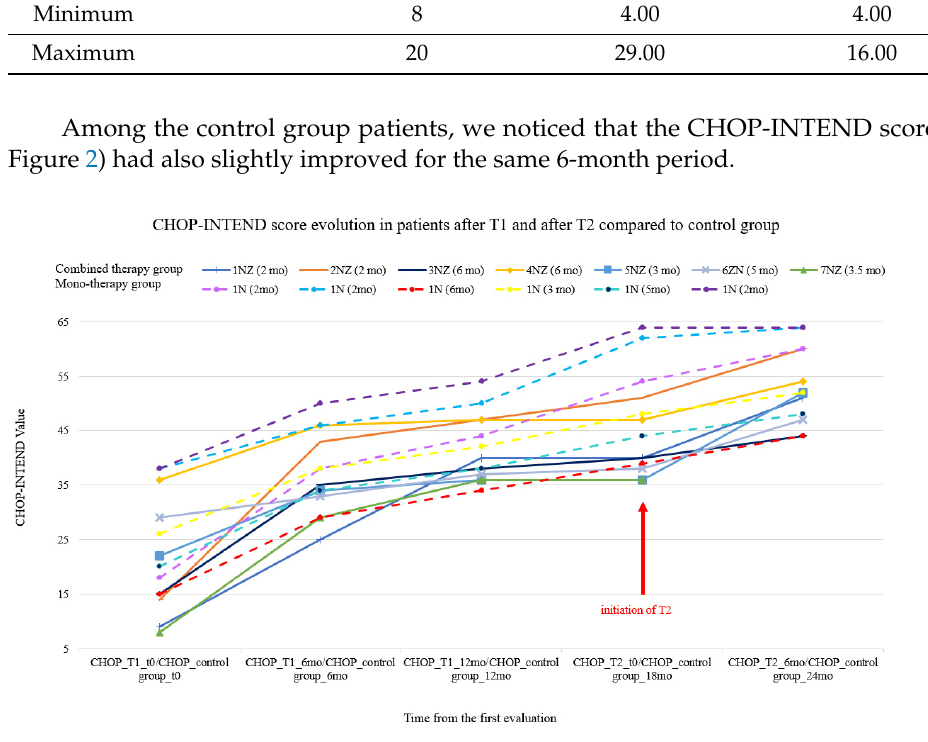
Figure 2. The Children’s Hospital of Philadelphia Infant Test of Neuromuscular Disorders (CHOP- INTEND) score evolution in the control group (dotted lines) and in patients after T1 and after T2 (each patient’s age at treatment initiation appears in parentheses above the graph).